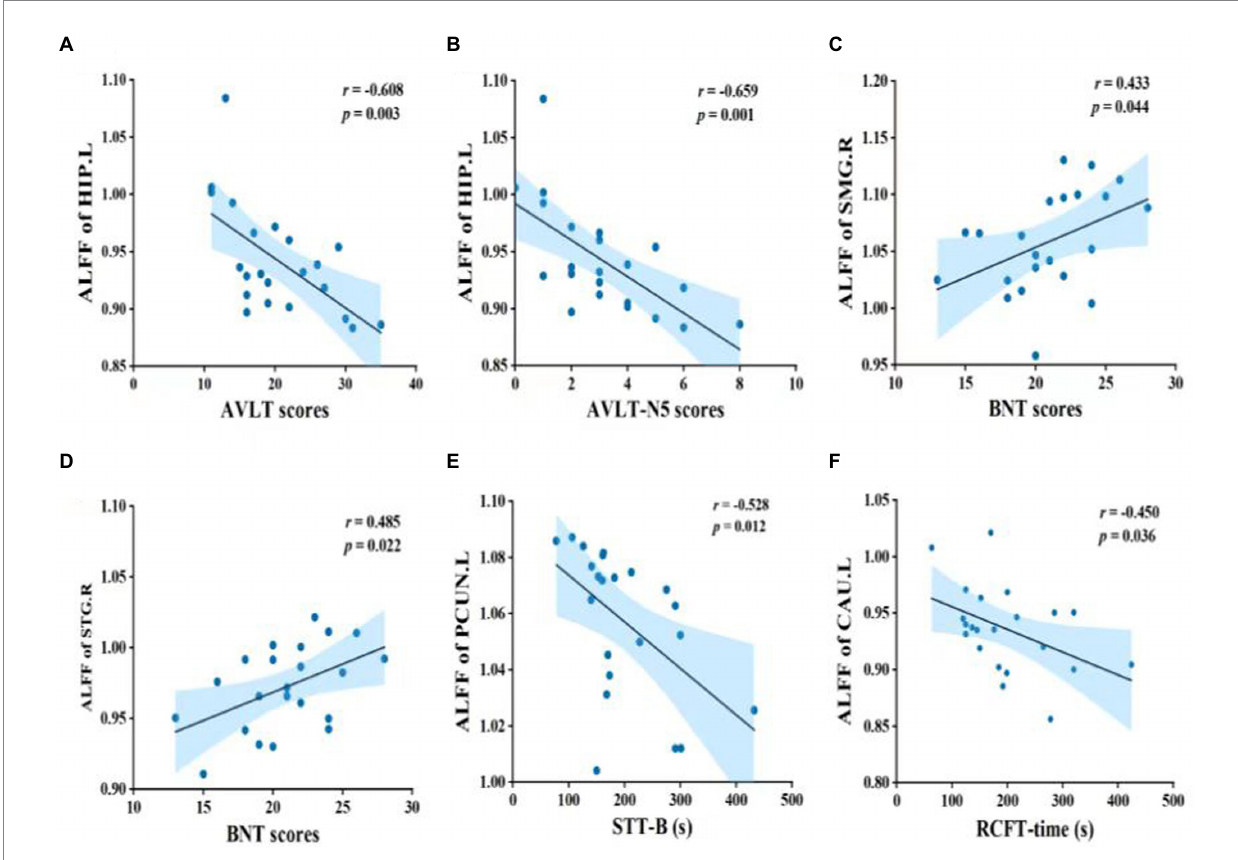
FIGURE 2 Pearson’s correlation between brain function and cognitive performance in MCI patients.